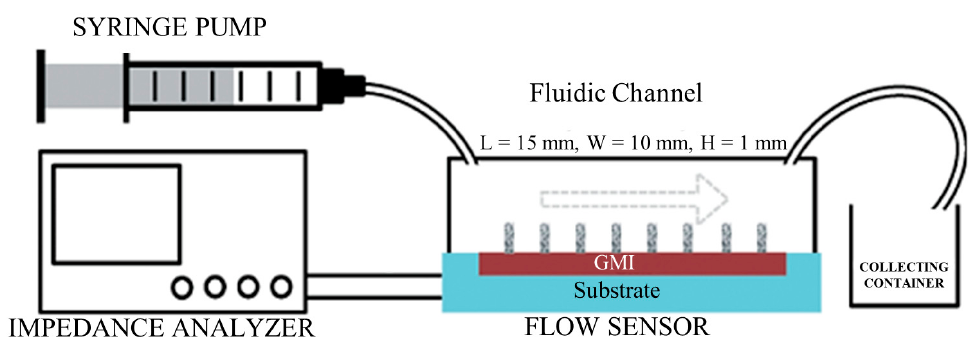
Figure 17. Experimental setup of the flow sensor designed by Ahmed Alfadhel. Reprinted with per- mission from Ref. [73]. Copyright 2014, ROYAL SOCIETY OF CHEMISTRY.